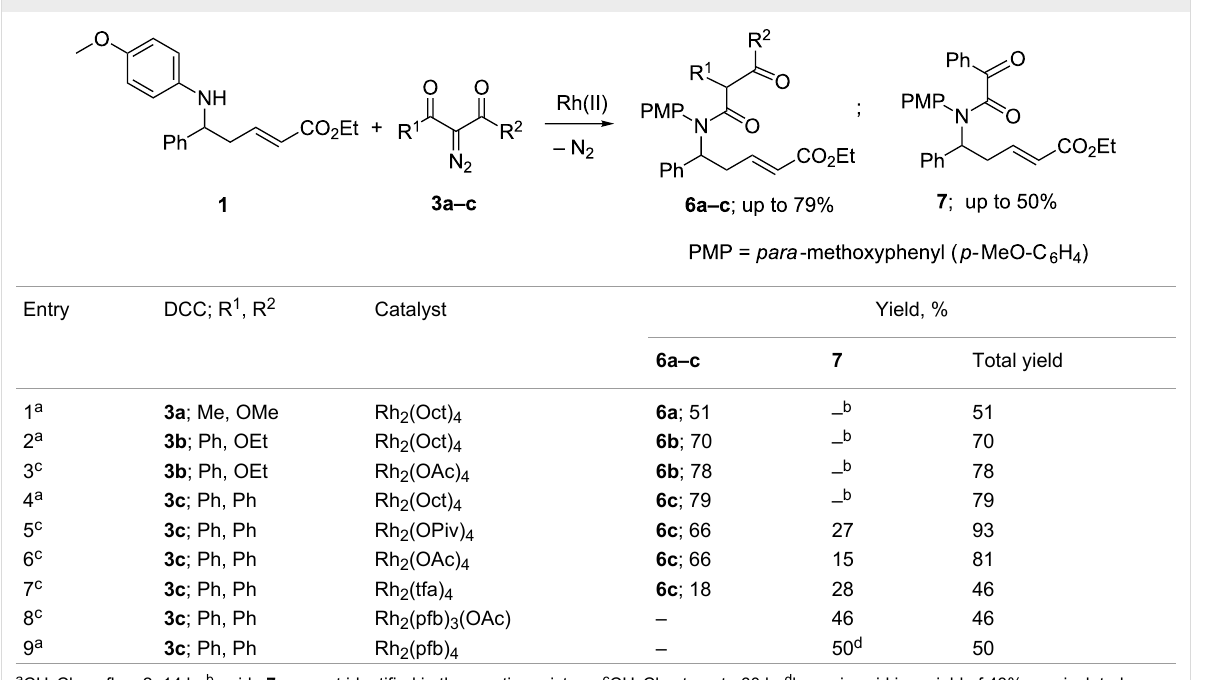
Table 2: Rh(II)-Catalyzed reactions of diazodicarbonyl compounds 3a-c with aminoester 1